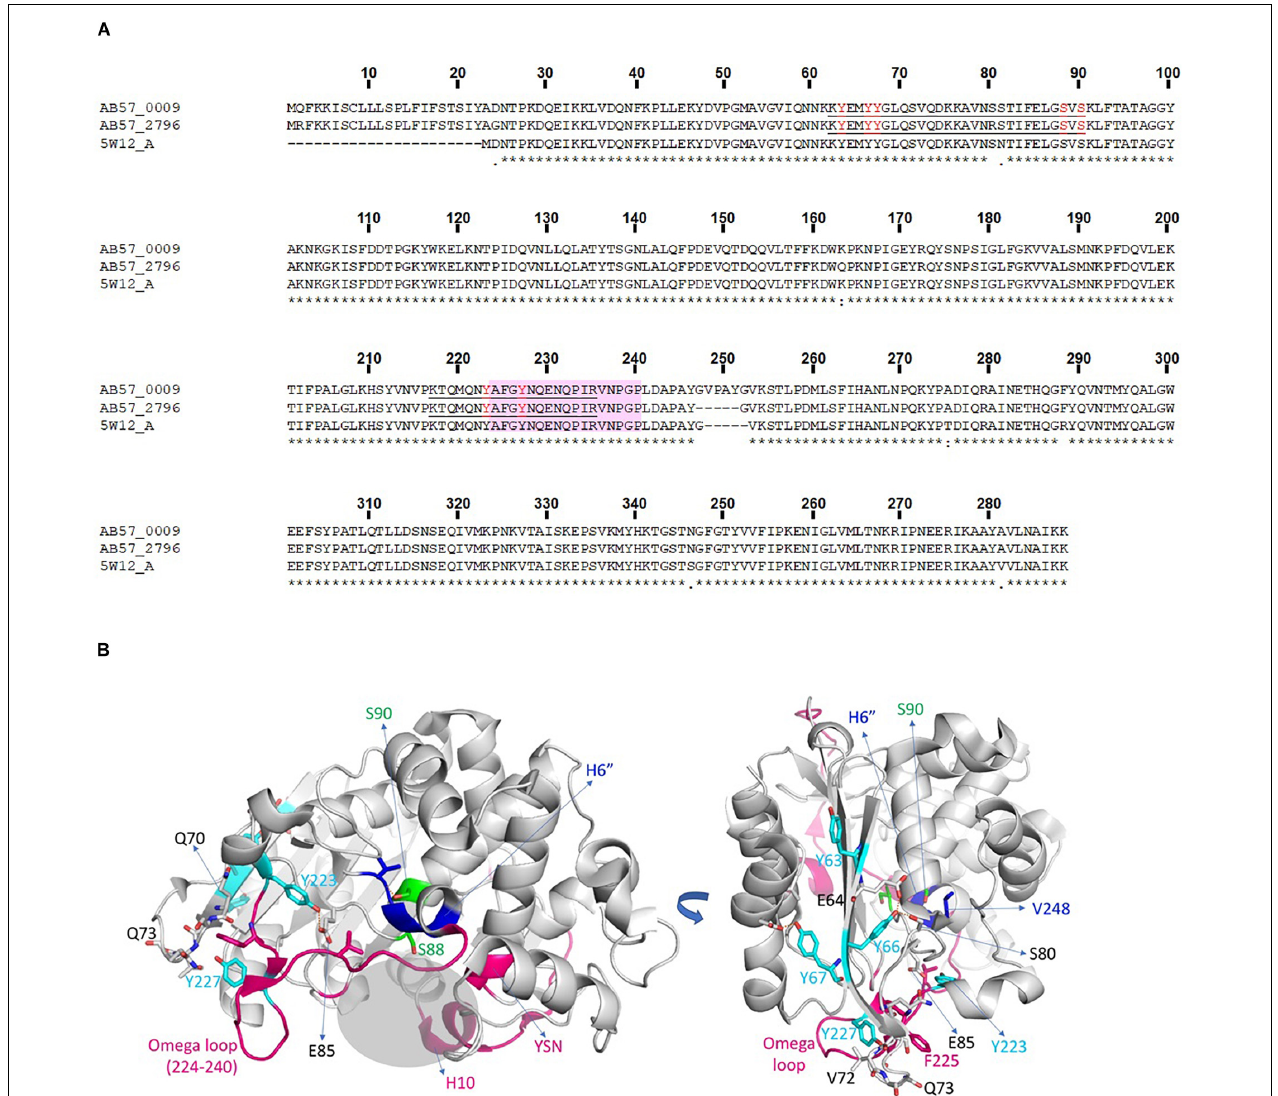
FIGURE 4 | β -lactamase phosphorylations. (A) Alignment of ADCs from A. baumannii AB0057 (AB57_0009 and AB57_2796) with β -lactamase 5W12-A in the PDB. Completely invariant residues are indicated with an asterisk (*), highly conserved regions are indicated with a colon (:) and semi-conserved residues are indicated with a dot (.). Identified peptides and phospho-sites in our study are underlined and in red. (B) Structural representation of a β -lactamase from A. baumannii solved in complex with an inhibitor (PDB code 5W12). The phosphoY residues are colored in cyan and the phosphoS residues in green. The residues interacting with the modified Y or S are represented in gray sticks, and the interaction interface is indicated by brown dotted lines. The additional five amino acids present in the AB57_0009 protein are located in the blue zone in the H6" helix. Structural regions flanking the binding site, carrying mutations involved in increased resistance, are colored in magenta. The binding site is shown with a gray shaded area. The structural regions lining the binding site, bearing the mutations implicated in an increase of resistance, are colored in magenta. The binding site is materialized as a gray shaded area.